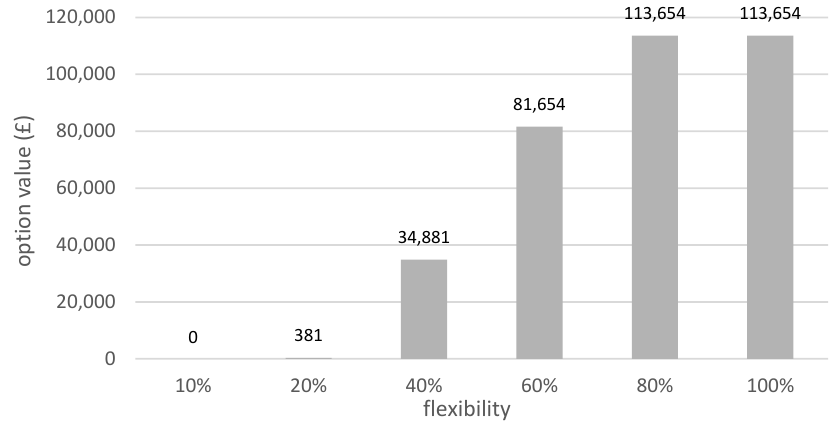
Figure 10. Option Value of Smart Charging of EV as a function of the Smart Charging flexibility, using BIF.